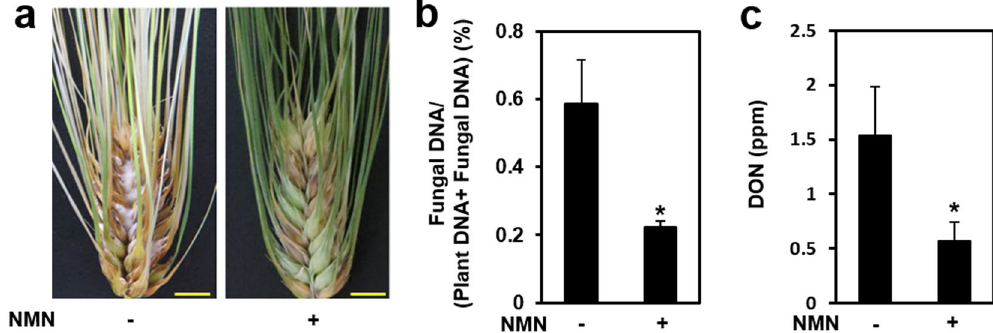
Figure 5. NMN pretreatment induces disease resistance against F. graminearum in barley. ( a ) NMN was sprayed on spikes of the FHB-susceptible line H.E.S.4, followed by incubation for 4 h. A conidia solution (1 × 10 4 conidia/ml) of F. graminearum was then applied by spraying (n = 3). ( a ) Scale bars: 1 cm. ( b ) F. graminearum gDNA was measured by qPCR. Error bars represent the standard deviation (n = 3) (Student’s t-test * P < 0.05). ( c ) DON was measured by QuickScan DON3 (n = 3) (Student’s t-test * P <